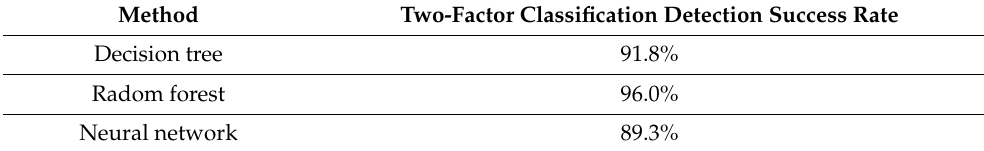
Table 13. Confusion matrix of random forest two-factor classification results.